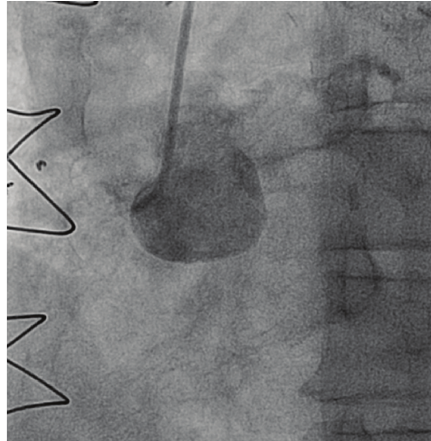
Figure 2: Chronically occluded RCA.